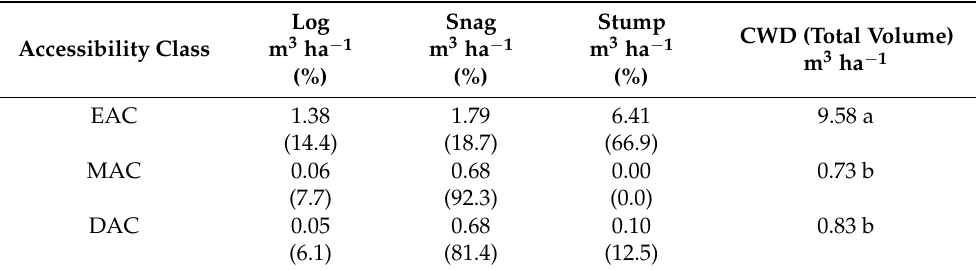
Table 1. Volume of CWD (m 3 ha − 1 ) components (downed log, snag and stump) in the accessibility classes, and results of ANOVA and Duncan tests.